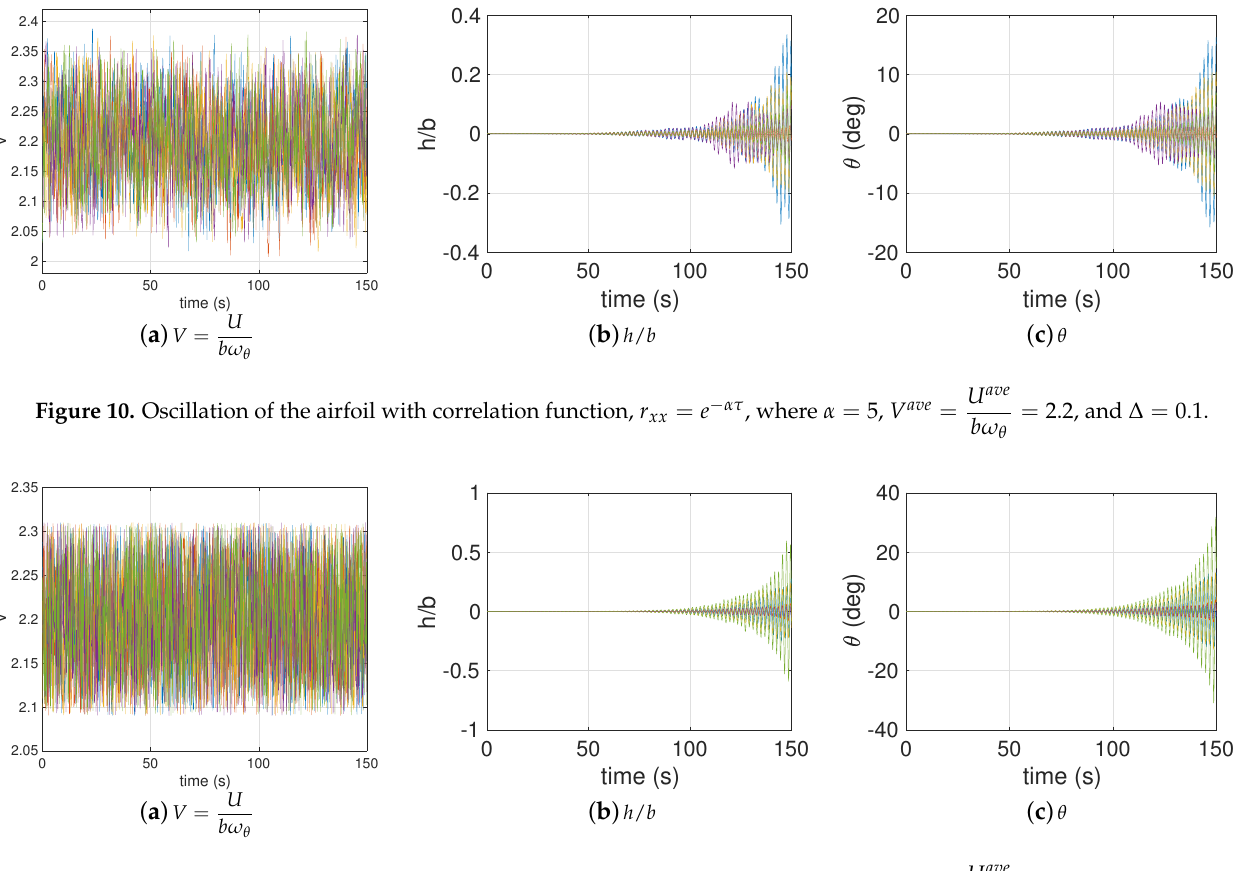
U ave = 2.2, and ∆ = b ω θ